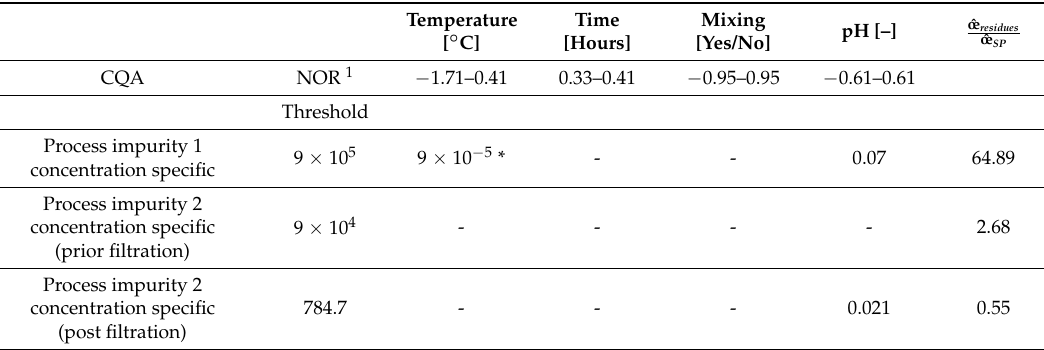
Table 2. p -values of significant process parameters that were used in the statistical models for each CQA of precipitation (PR). Normal operating ranges or thresholds are given for each process parameter or critical quality attribute. Non-significant parameters are indicated with “-”. Also, the ratio of standard deviation of raw residuals of the model by the standard deviation at set-point ( ˆ σ residues each